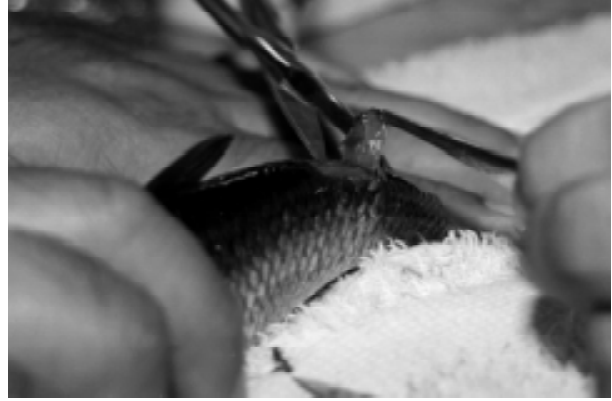
Figure 2 - Longitudinal slice for muscle biopsy.